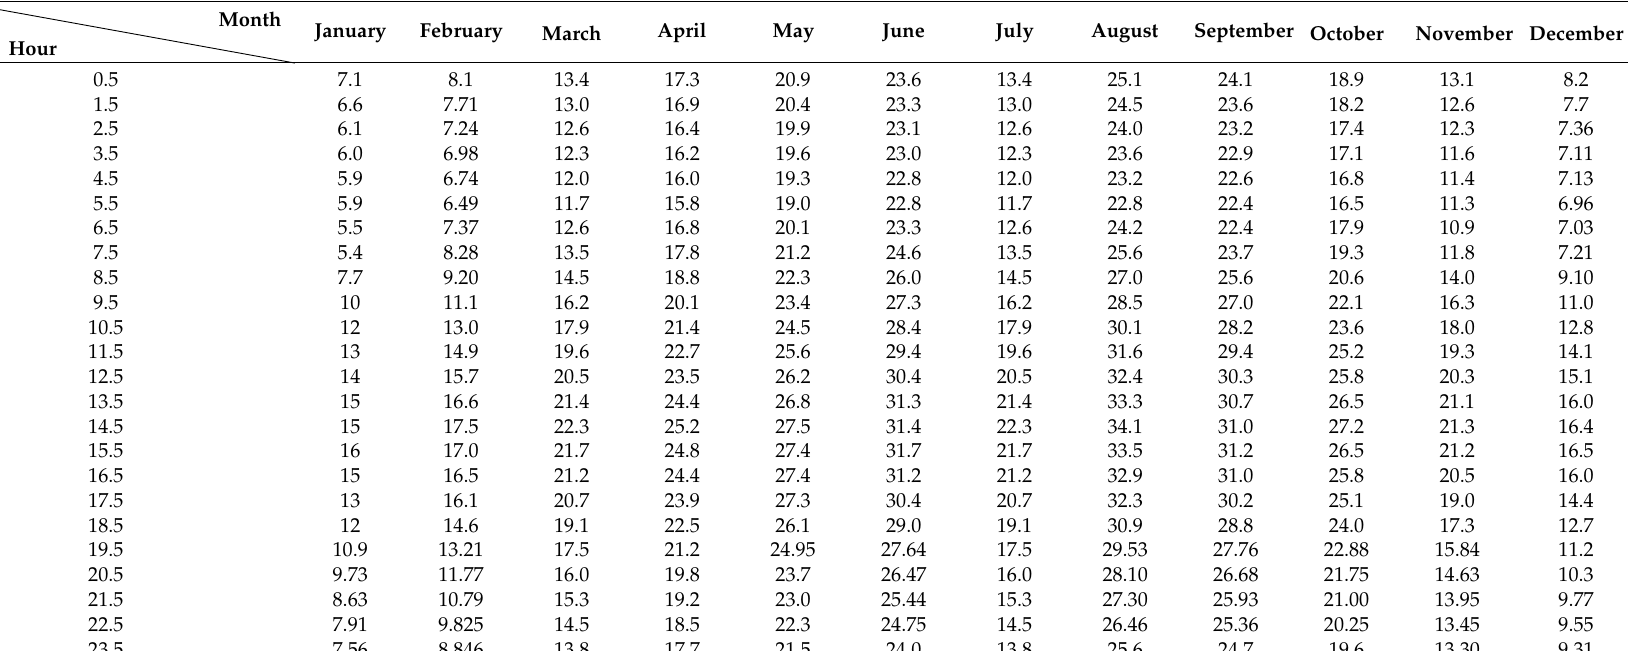
Table A1. Average hourly dry bulb temperature ( ◦